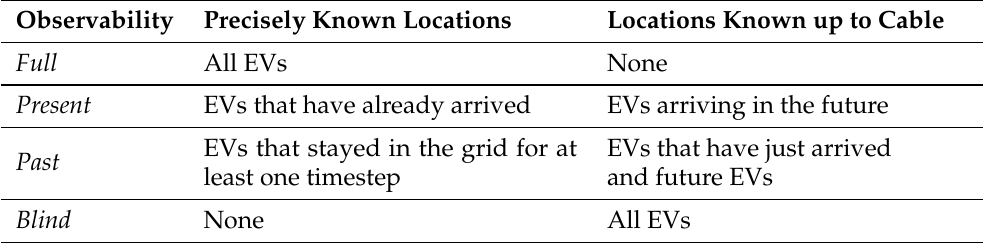
Table 2. Four degrees of observability of the EV locations.